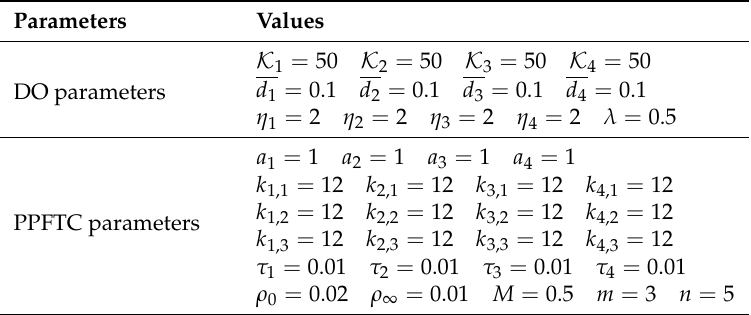
Table 3. Parameters used in the proposed disturbance observer (DO) and prescribed performance fault-tolerant controller (PPFTC).